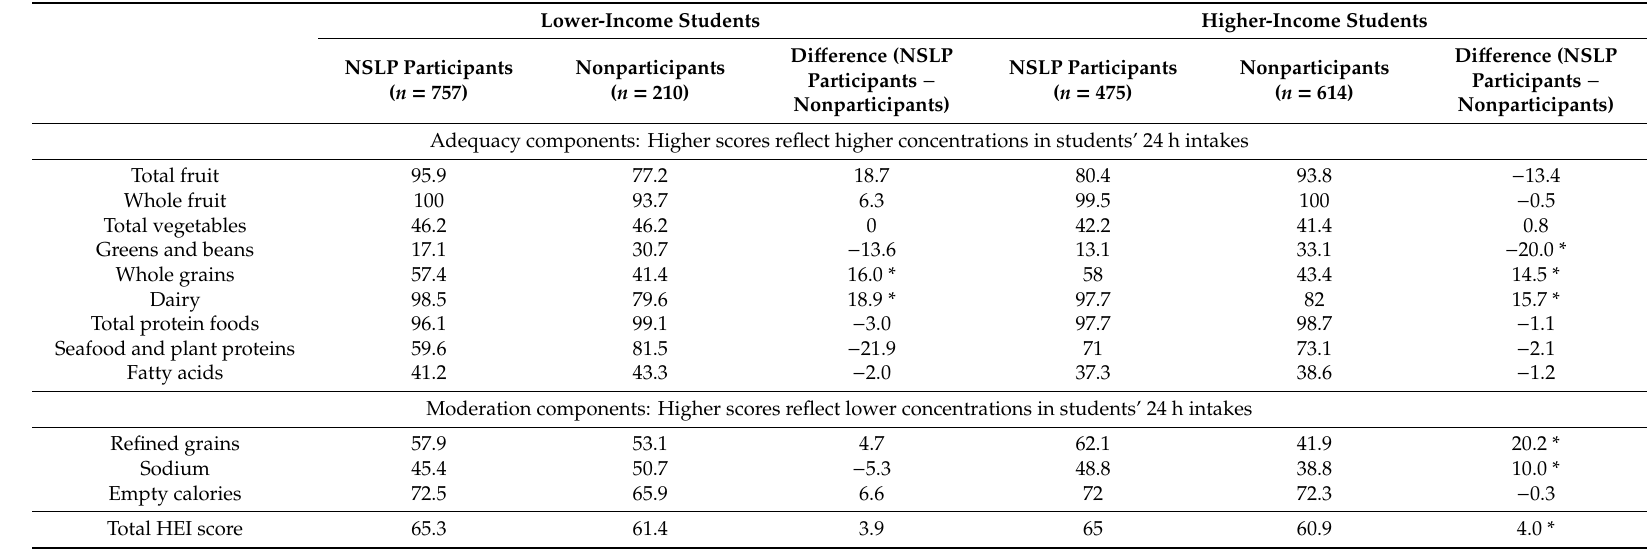
Table 4. Di ff erences between NSLP participants and nonparticipants in mean HEI-2010 scores for 24 h intakes, by household